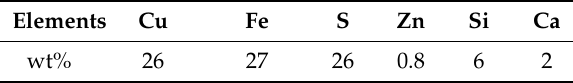
Table 1. Chemical composition of chalcopyrite